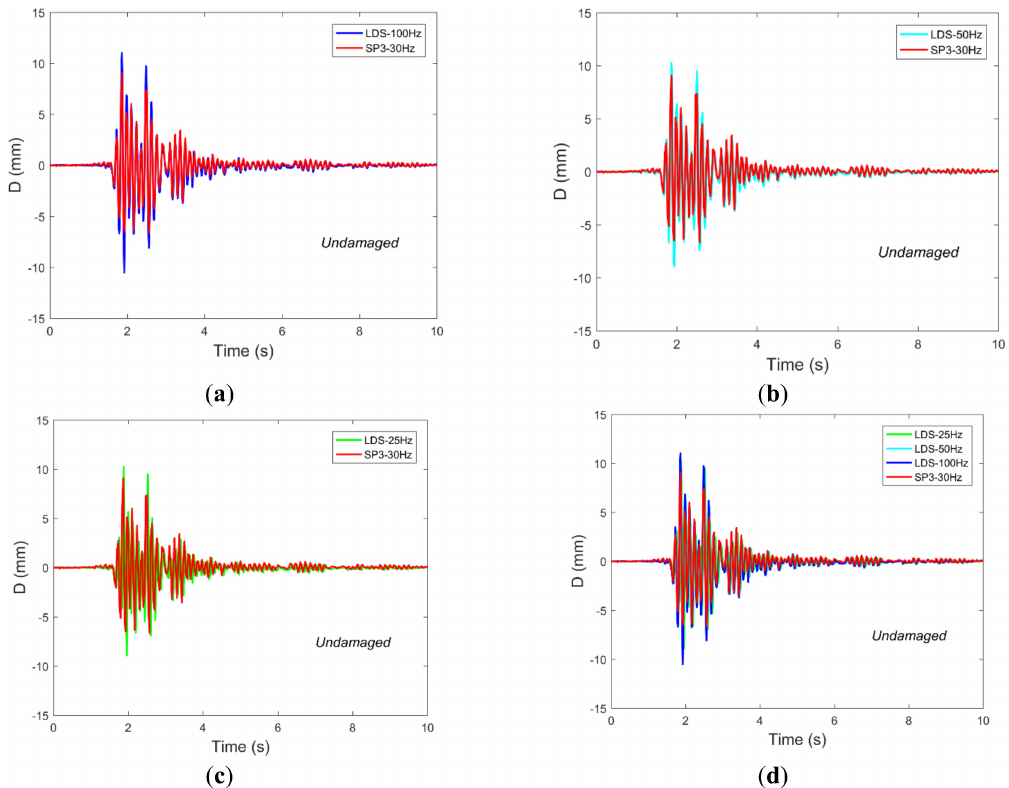
Figure 9. The displacement time-history responses as collected by SPs compared with LDSs using different sampling rates of ( a ) 100 Hz, ( b ) 50 Hz, and ( c ) 25 Hz. ( d ) A comparison of all sampling rates. Table 6. Peak values displacement of SPs and LDSs with different